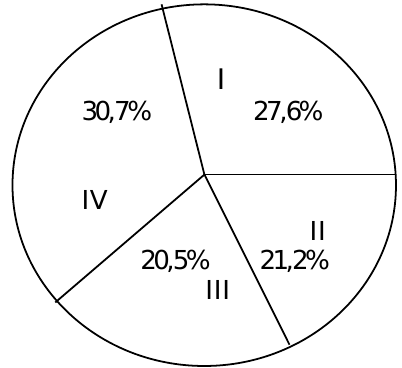
Fig. 6. Diagram of structure of 1 st – 2 nd year girl students’ physical health’s integral indicator; I – factor of general dispersion (body mass index and Robinson’s index); II – factor of general dispersion (biological age and life index); III – factor of general dispersion (power index and restoration time after load by Martinet-Kushelevskiy’s test); IV – factor of general dispersion (medium components, which were not taken into